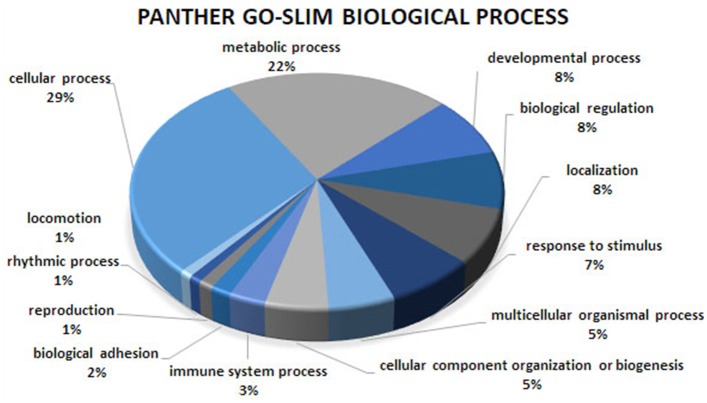
Biological process analysis of the co-association network for meat quality complex. The PANTHER overrepresentation test grouped 609 annotated genes into 13 biological processes.